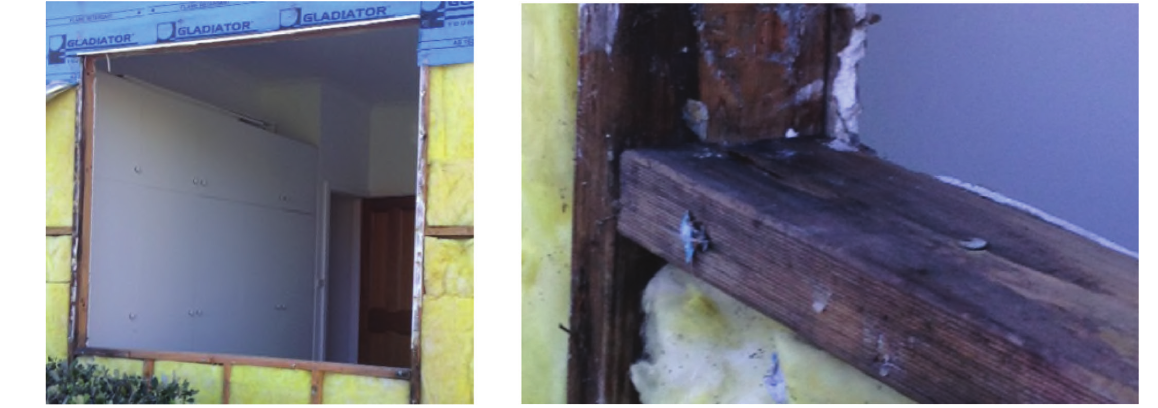
Example of moisture ingress causing degradation of timber framing in Australian residential